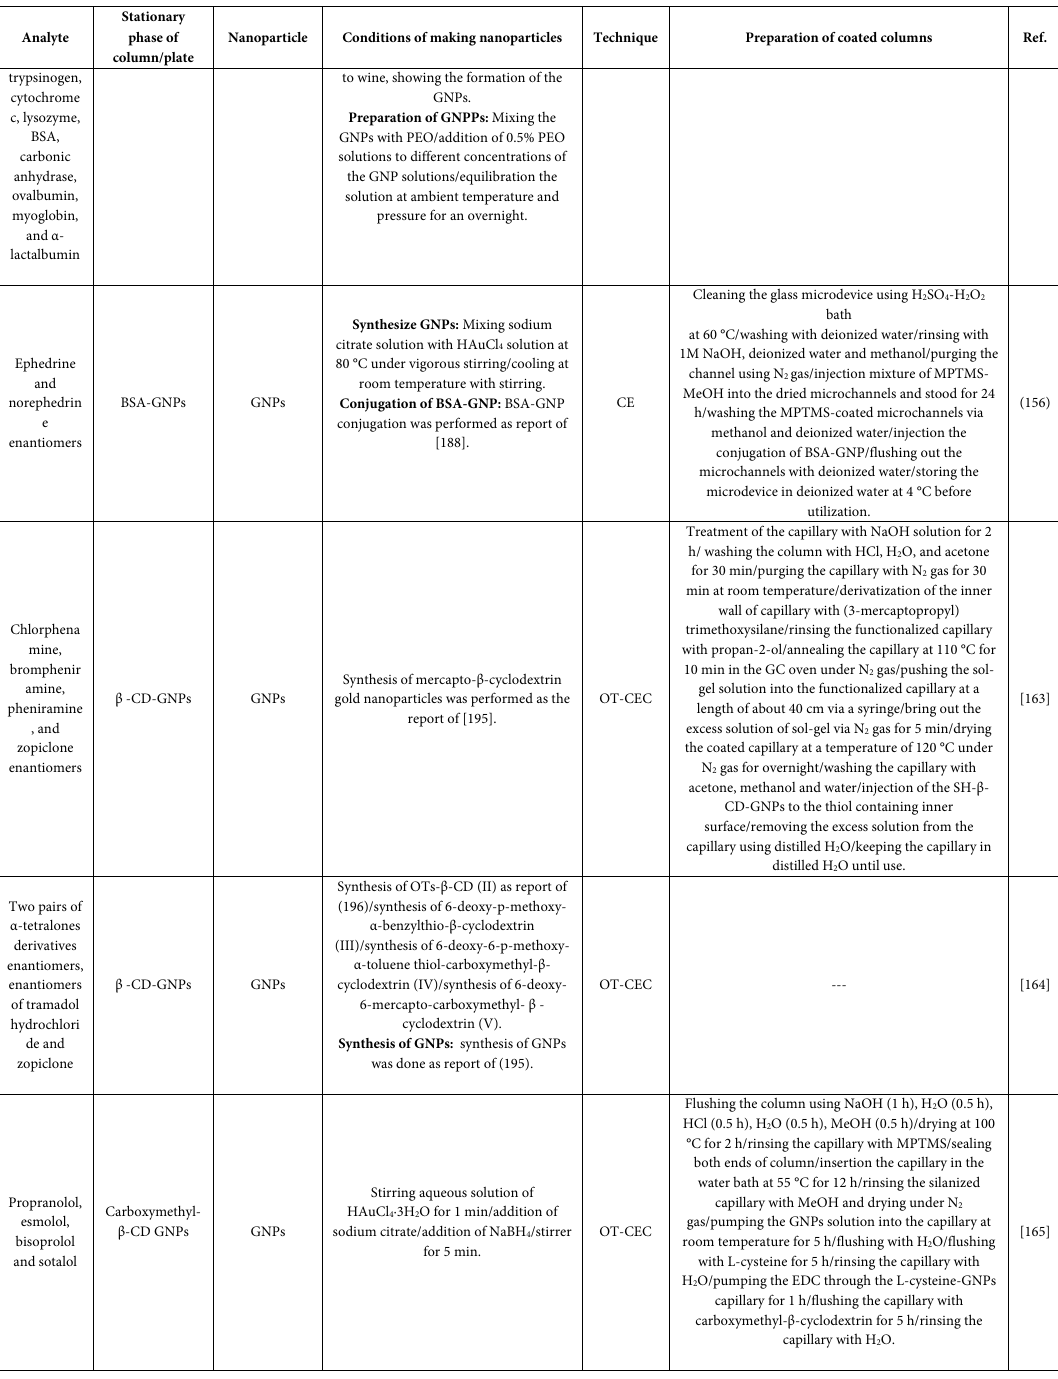
Stationary Analyte phase of Nanoparticle Conditions of making nanoparticles Technique Preparation of coated columns Ref. column/plate to wine, showing the formation of the GNPs. Preparation of GNPPs: Mixing the GNPs with PEO/addition of 0.5% PEO solutions to different concentrations of the GNP solutions/equilibration the solution at ambient temperature and pressure for an overnight.